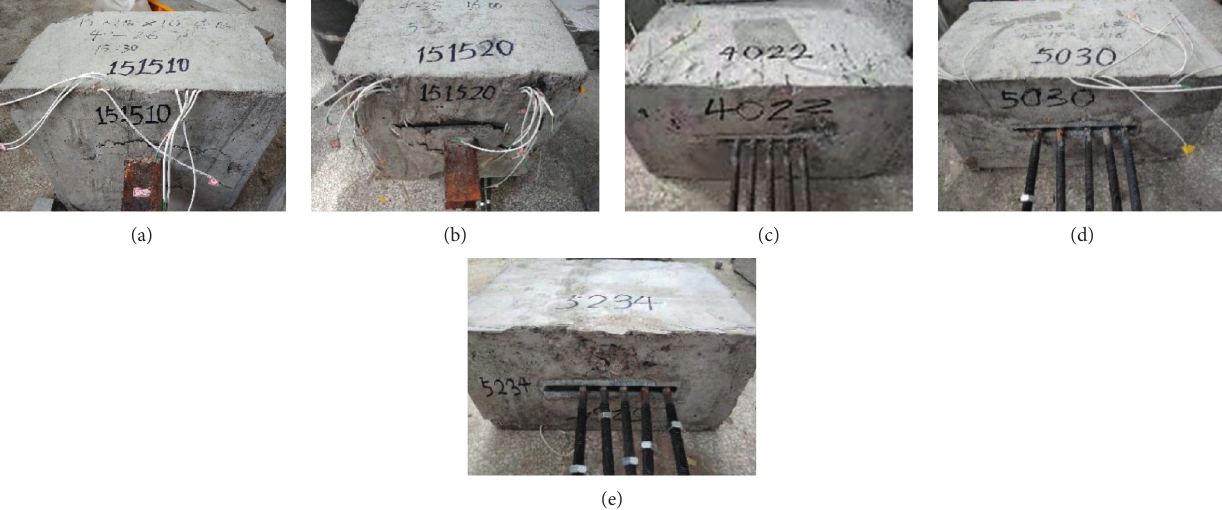
Figure 5: Specimen failure form for (a) A-1, (b) A-2, (c) B-1, (d) B-2, and (e)